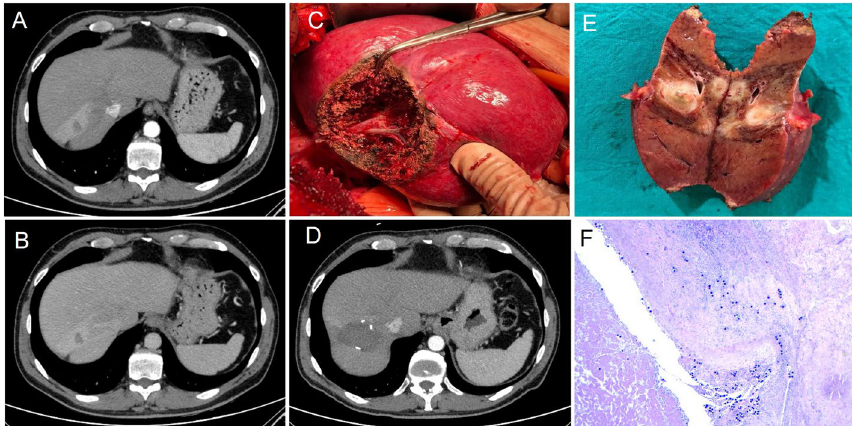
Fig. 5 Post-treatment images of the patient diagnosed with HCC (Fig. 4): The CT study to assess response at 3 months ( A and B ) showed a 15-mm focal lesion in segment VII without contrast enhancement that could suggest tumor persistence or recurrence. After hepatic segmentectomy ( C and D ) performed 9 months after radioembolization, a resection cavity was shown, without focal hepatic lesions suggestive of tumor recurrence. Finally, the pathological study of the surgical piece ( E and F ) showed a fibronecrotic nodule in relation to the embolization material without the presence of residual